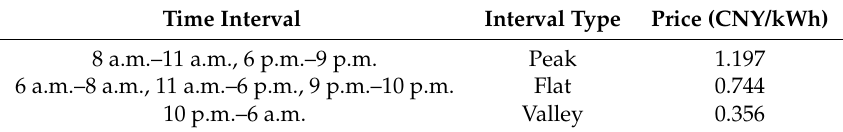
Table A2. Peak/flat/valley electricity price formulated by the Guizhou Grid.